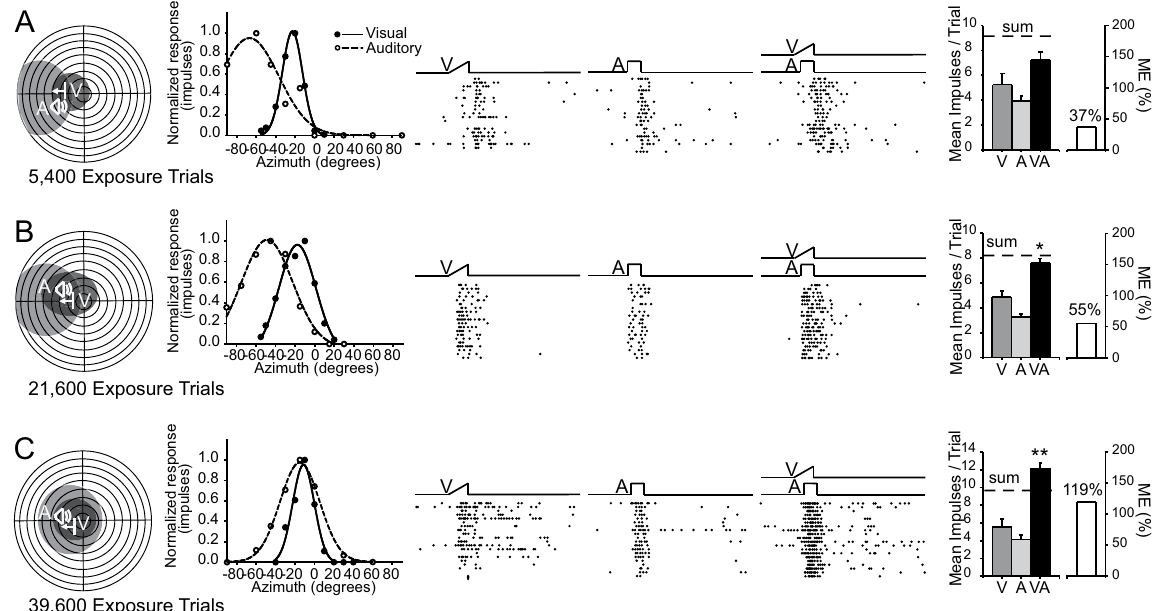
Figure 7. Exemplars illustrate a gradual development of multisensory integration capabilities, and receptive field register, during the cross-modal exposure period. Shown are 3 typical neurons recorded from the same noise-reared animal after being exposed to an increasing number of cross-modal stimuli. Below each schematic are the numbers of exposures (5,400 trials ≈ 9 hours of experience; 21,600 ≈ 36 hours; 39,600 ≈ 66 hours) provided prior to the tests generating these data. Conventions are the same as in Figs 2 and 3. Left: The RFs and visual and auditory spatial response profiles increased their overlap with increased cross-modal exposure. Middle: rasters and summary graphs show progressive increases in multisensory enhancement with increasing cross-modal exposure. Right: Summary of the changes in responsiveness and ME. * P < 0.05. Conventions are the same as in previous